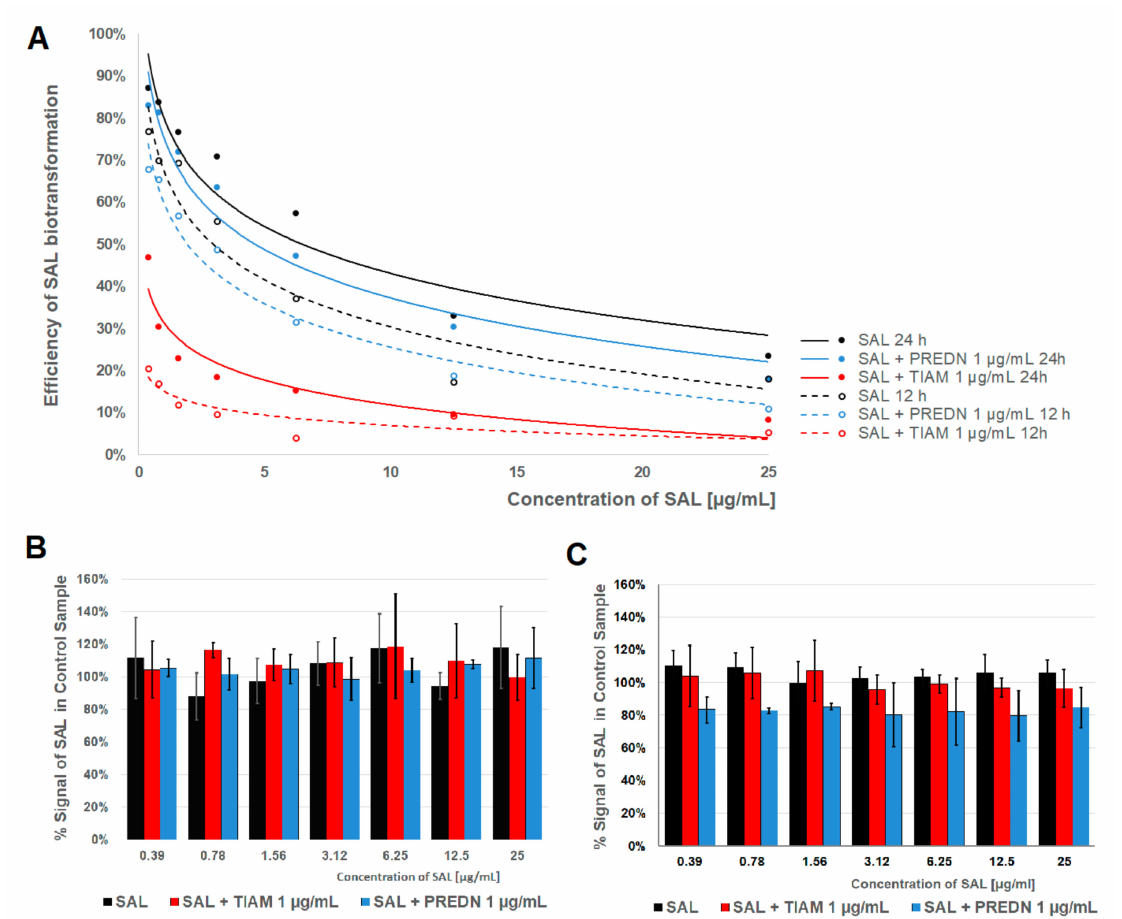
Figure 2. E ffi ciency of biotransformation of salinomycin (SAL) in three cell models. ( A ) Percent decrease of the SAL signal in comparison to control samples in PHH exposed to drug(s) for 12 and 24 h. ( B ) Percent of the SAL signal in comparison to control samples in Balb / c 3T3 fibroblasts exposed to drug(s) for 24 h. ( C ) Percent of the SAL signal in comparison to control samples in HepG2 cells exposed to drug(s) for 24